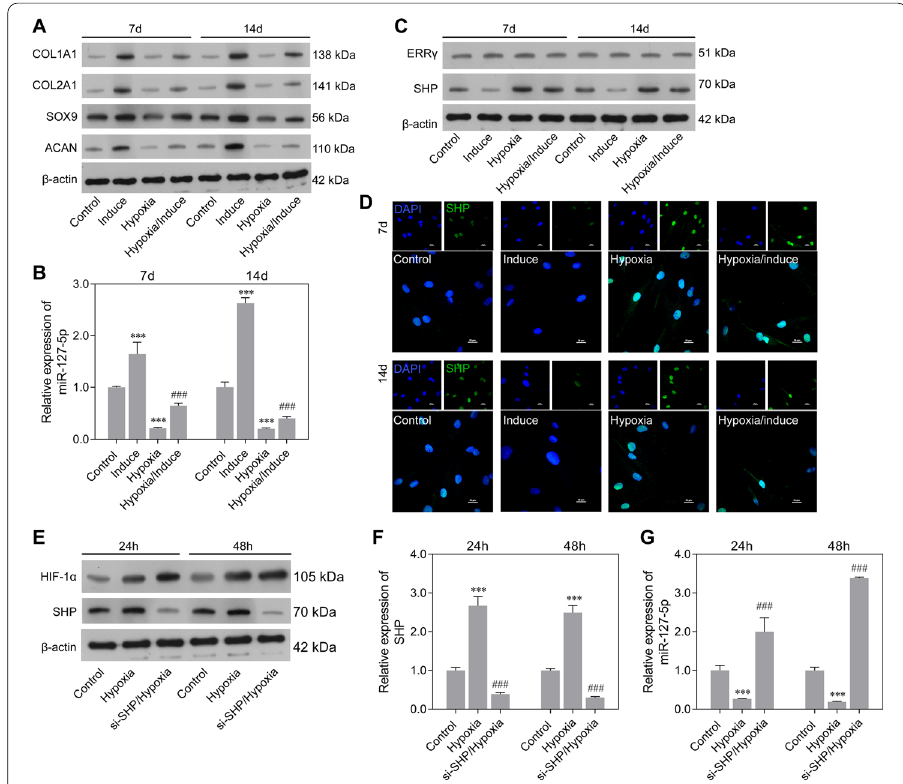
Fig. 2 Expression and transcriptional regulation of miR-127-5p during chondrogenic differentiation of rMSCs under hypoxic conditions. The rMSCs were induced to undergo chondrogenic differentiation under hypoxic conditions (1% O 2 ) for 7 and 14 days. A Expression of COL1A1, COL2A1, SOX9, and ACAN proteins in rMSCs in the control, induction, hypoxia, and hypoxia/induction groups was detected by western blotting. B MiR-127-5p expression was determined by quantitative real-time PCR analysis. C Transcriptional factors (ERRγ and SHP) were analyzed by western blotting. D SHP protein expression was detected by immunofluorescence. rMSCs were transfected with si-SHP, followed by hypoxia intervention for 24 and 48 h. E Western blotting was performed to examine the relative levels of HIF-1α and SHP protein expression in rMSCs from the control, hypoxia, and si-SHP/hypoxia groups. Quantitative real-time PCR was used to examine SHP ( F ) and miR-127-5p expression ( G ). Results represent the mean value standard deviation of data obtained ± from three independent experiments. *** p < 0.001, compared with control; ### p < 0.001, compared